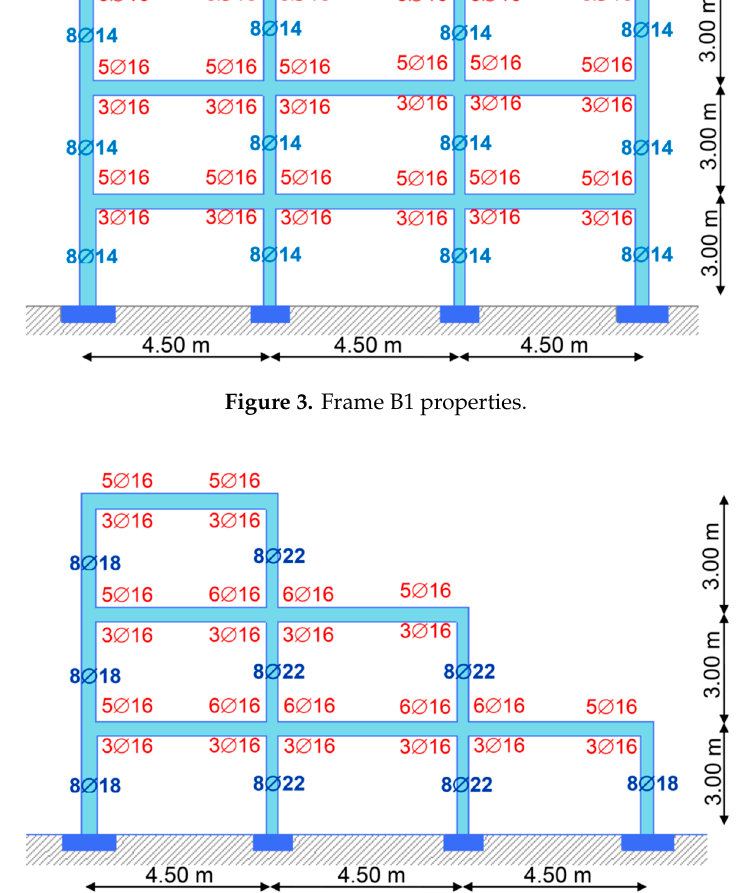
Figure 4. Frame A2 Figure 4. Frame A2 properties. Figure 4. Frame A2 properties. Figure 4. Frame A2 properties.